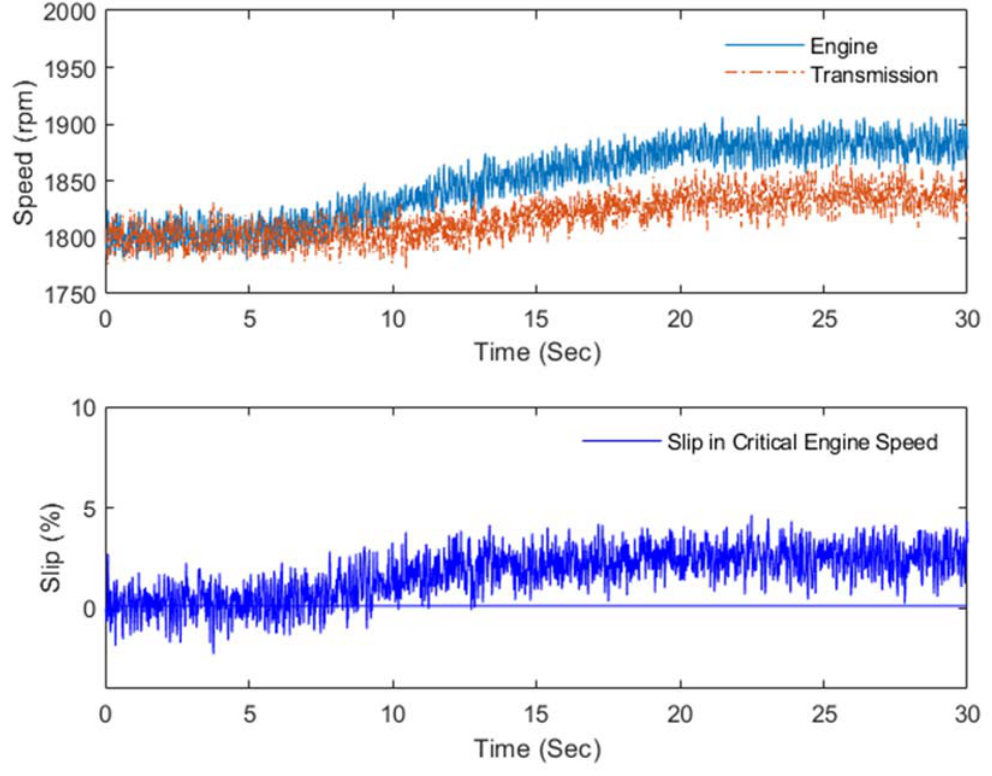
Figure 14. Regulation of vibration.